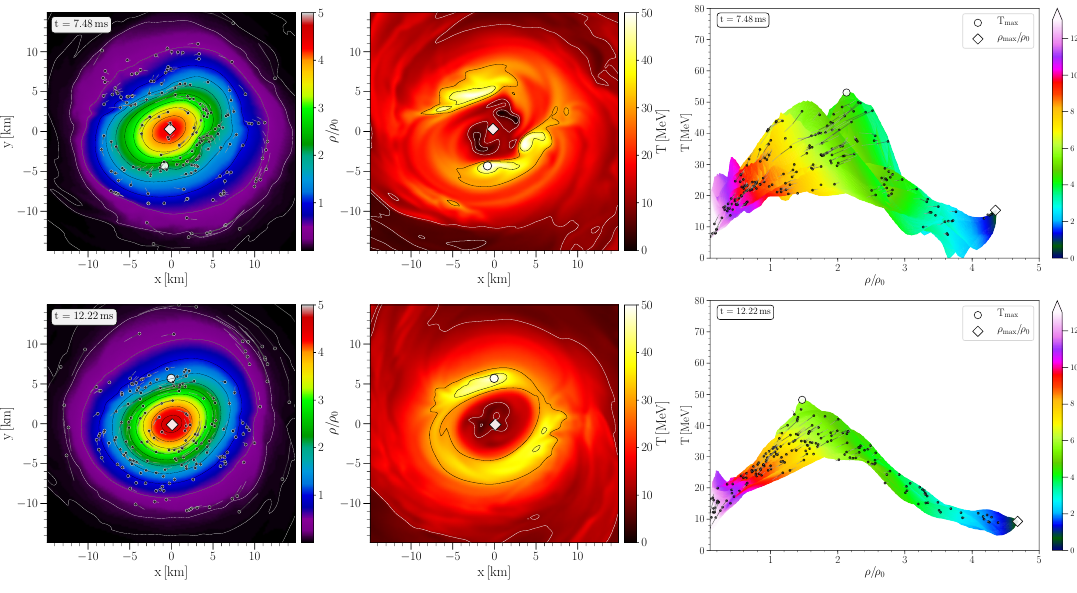
Figure 4. Same as Figure 3 but for later time